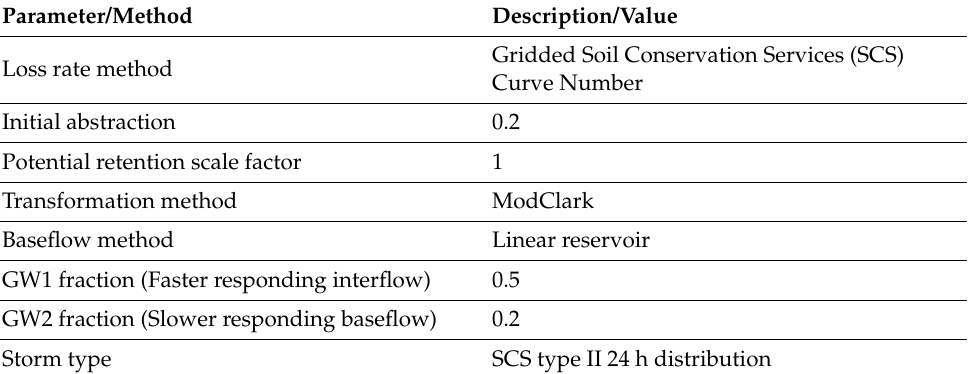
Figure 2. HEC-HMS gridded ModClark modeling in WMS platform. Table 1. Hydro-meteorological modeling methods, parameters, and their values for stormwater runoff calculation .